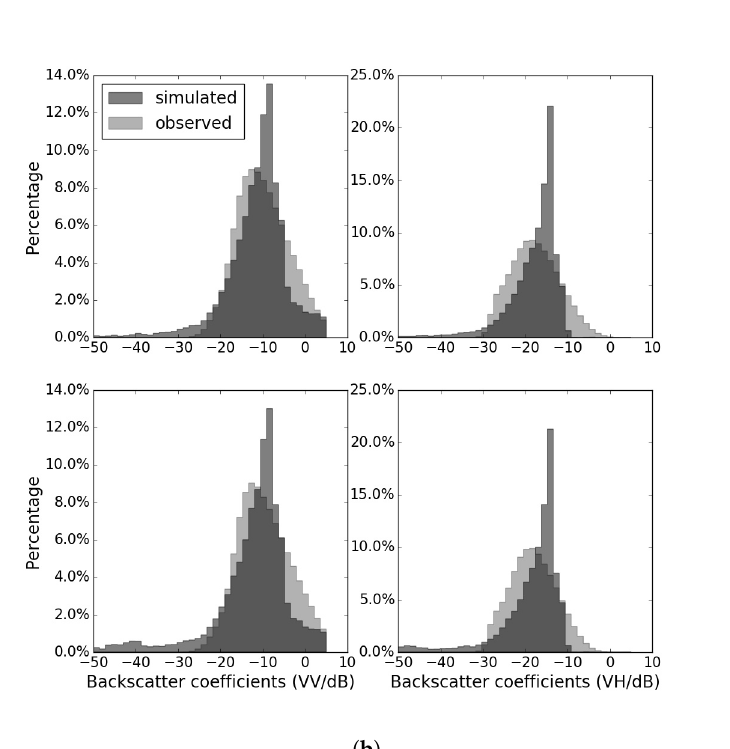
Figure 5. Distributions of the backscatter signal simulated (dark grey) and observed (light grey) for VV ( left ) and VH ( right ) polarizations in decibels and for snow free dates (summer). Two dates for each orbit are represented: ( a ) 25 July 2016 ( top ) and 18 August 2016 ( bottom ) for ascending orbit; and ( b ) 18 July 2015 ( top ) and 16 September 2015 ( bottom ) for descending